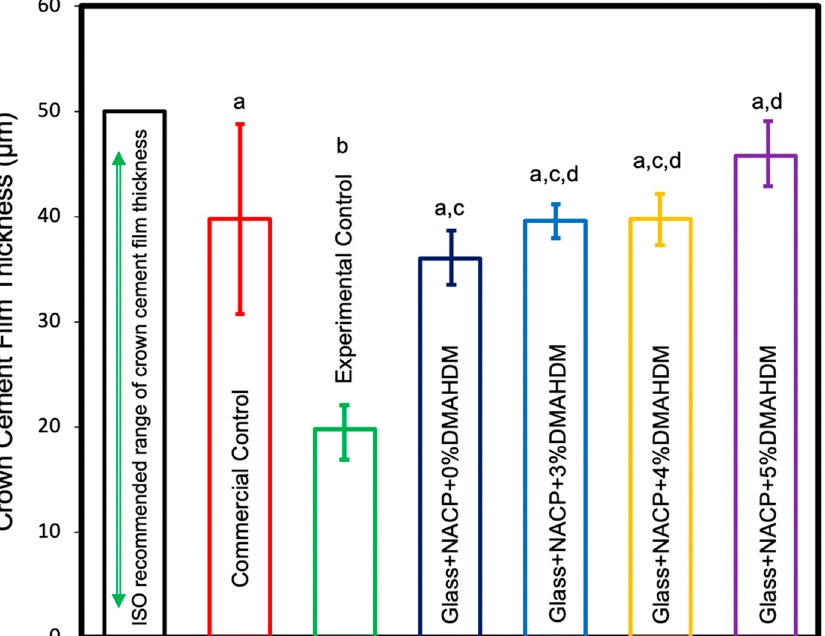
Figure 4. Cement film thickness (mean ± SD; n = 5). Adding 3%, 4%, and 5% DMAHDM